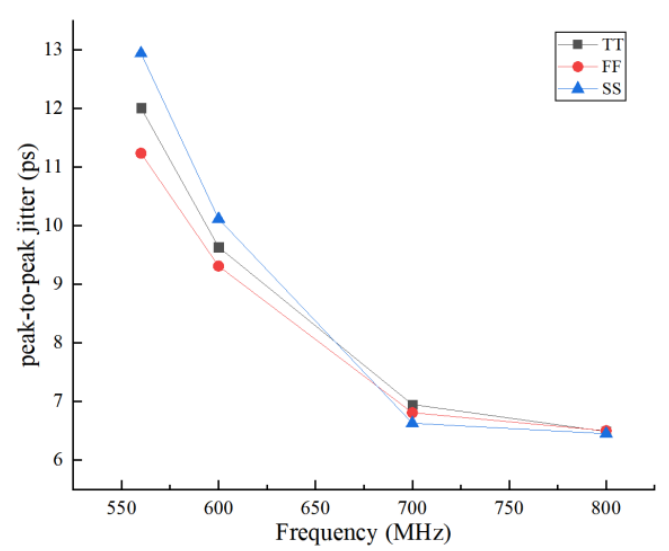
Figure 18. The variation of peak-to-peak jitter with respect to a different process.